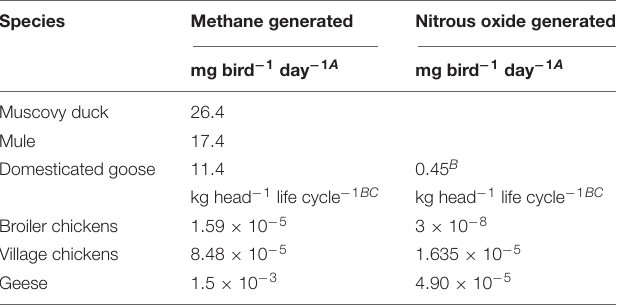
TABLE 5 | Generation by methane and nitrous oxide by